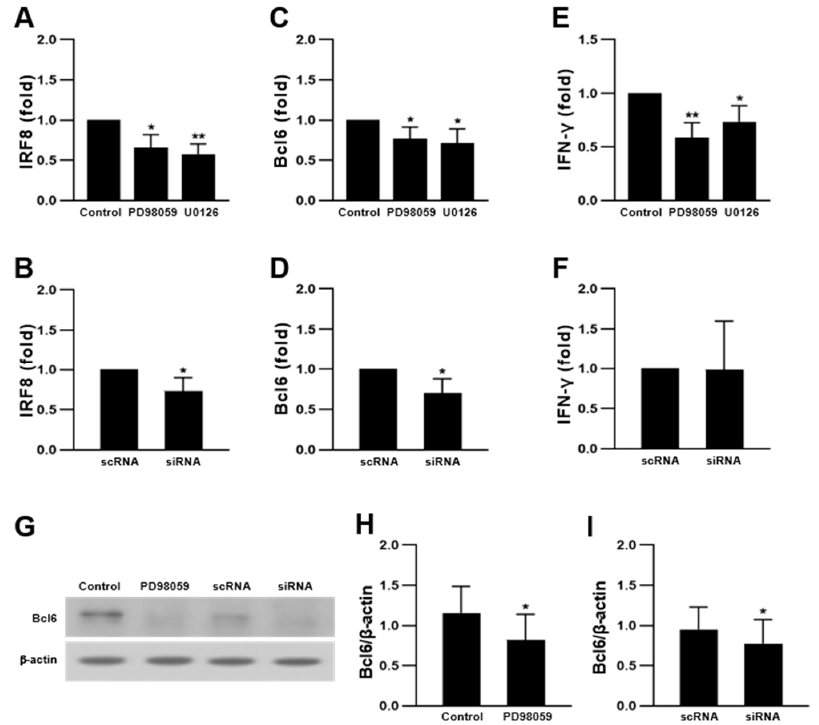
Figure 6. Inhibition of ERK suppressed the expression of inhibitory mediators of OC differentiation. RAW 264.7 cells treated with 5 µ M PD98059 and 2 µ M U0126 or transfected with ERK2 siRNA,